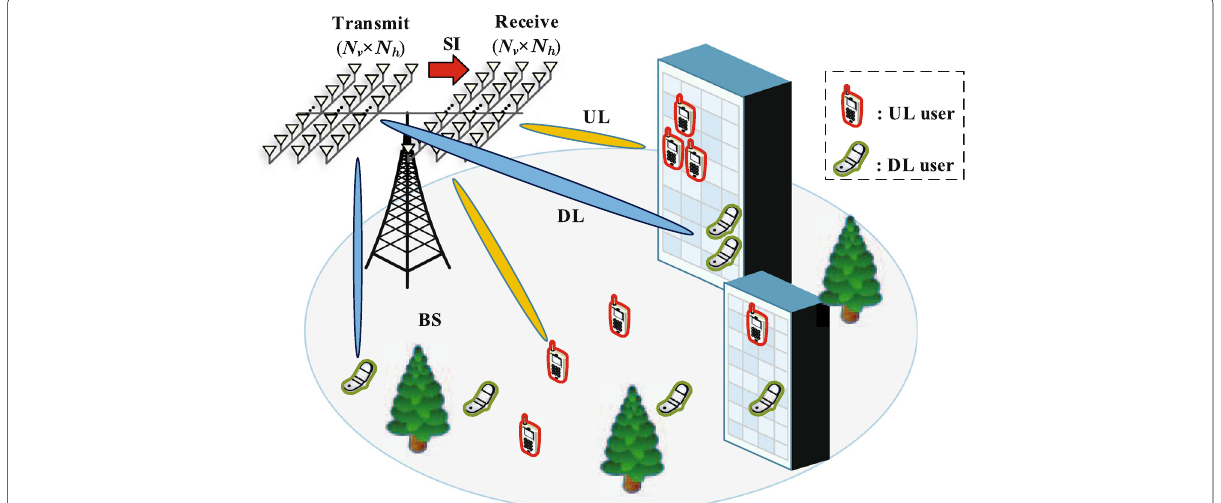
Fig. 1 Single-cell multiuser 3D massive MIMO